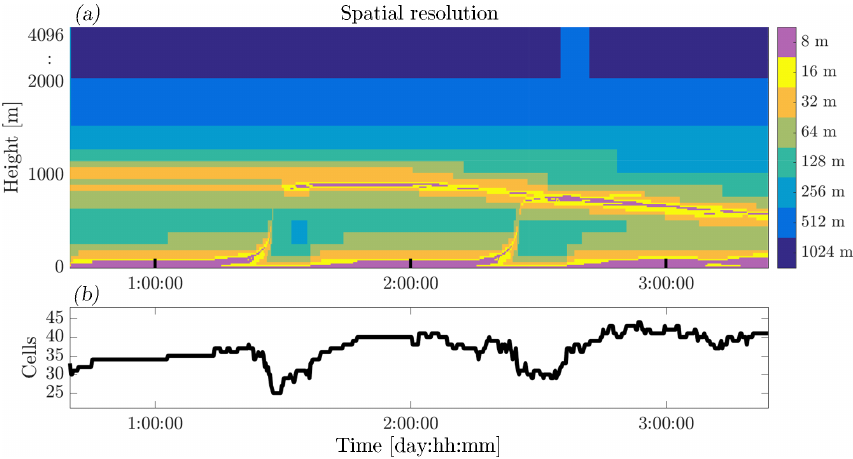
Figure 8. Evolution of (a) the vertical spatial resolution and (b) the total number of grid cells, for the GABLS2 inter-comparison case. Two full diurnal cycles, corresponding to 23 and 24 October 1999 (ranging from the labels 1:00:00 to 3:00:00 on the x axis).